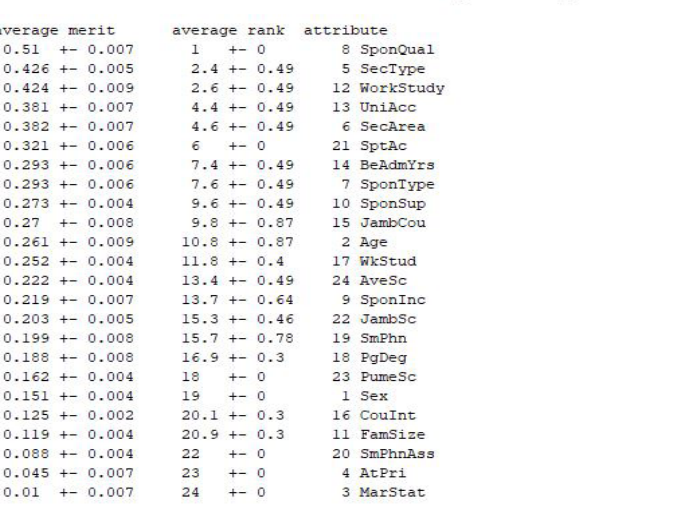
Table 4: Comparison of models’ performance on test dataset, based on correctly and